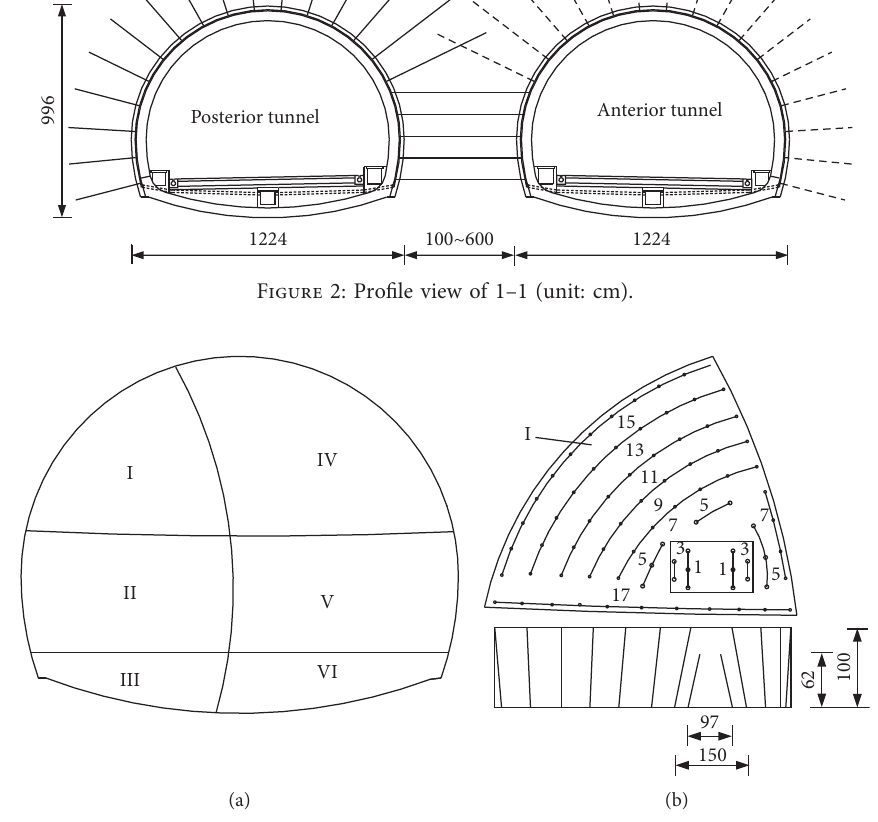
Figure 3: (a) CRD method and (b) blast-hole layout (unit: mm) in the posterior